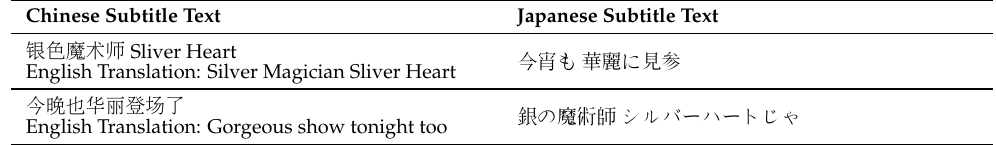
Table 3. Examples of mistranslations.